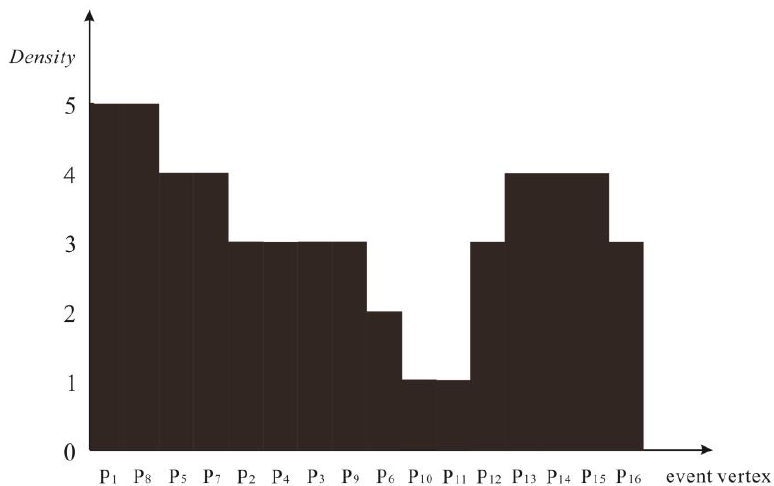
Figure 5. A density ordering graph of simulated dataset. It is a bar chart where the horizontal axis is the identifier of event points and the ordinate is the density of each event point. Table 2. Pseudocode of Generating Density Ordering Table and